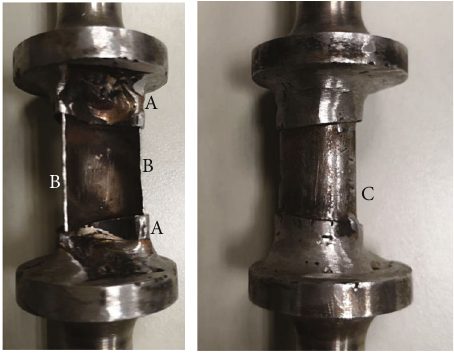
Figure 2: Welded blade